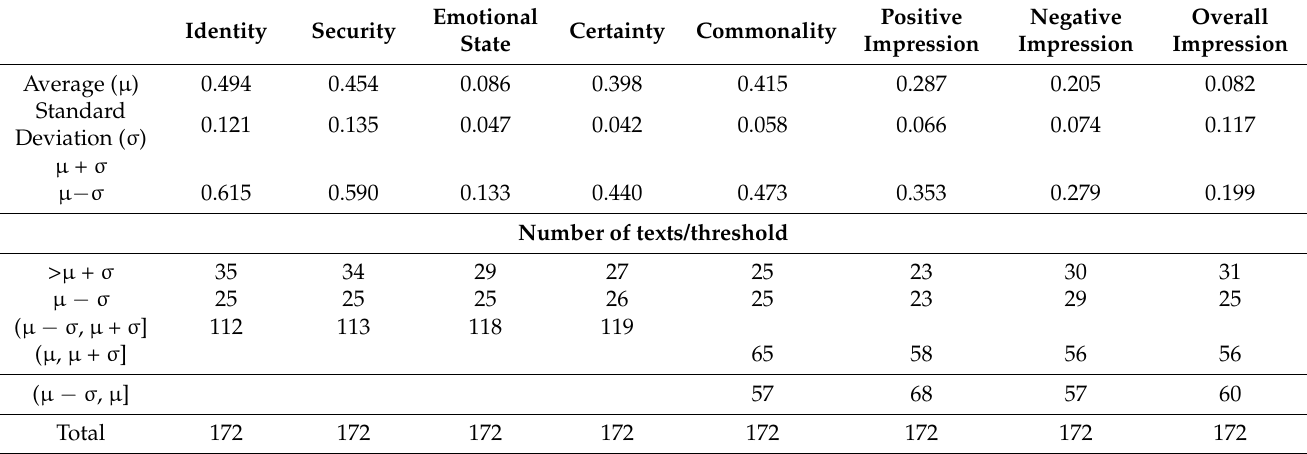
Table 2. The results for the measures of general attitudes